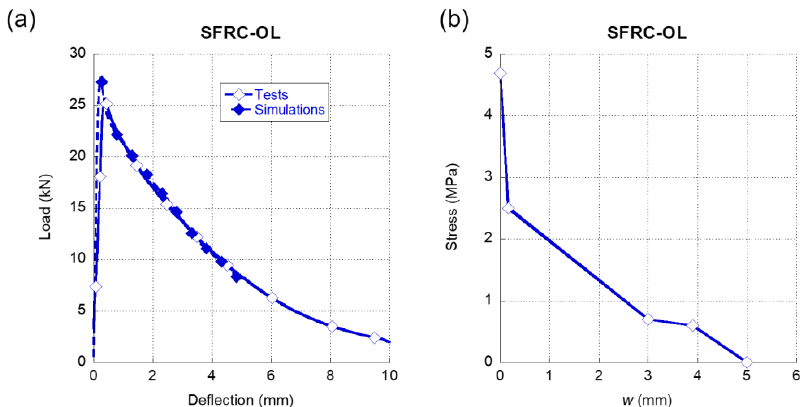
Figure 4. ( a ) Comparison of the average experimental results obtained in the fracture tests of SFRC-OL and the numerical simulation. ( b ) Softening function used in the simulation shown in ( a ).